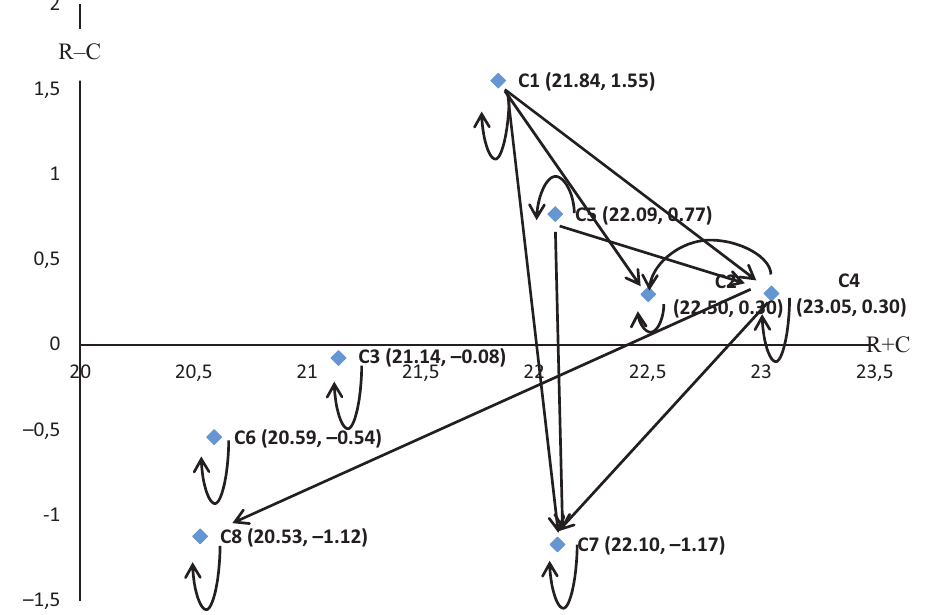
Fig. 4. Network Relation Map (NRM) within